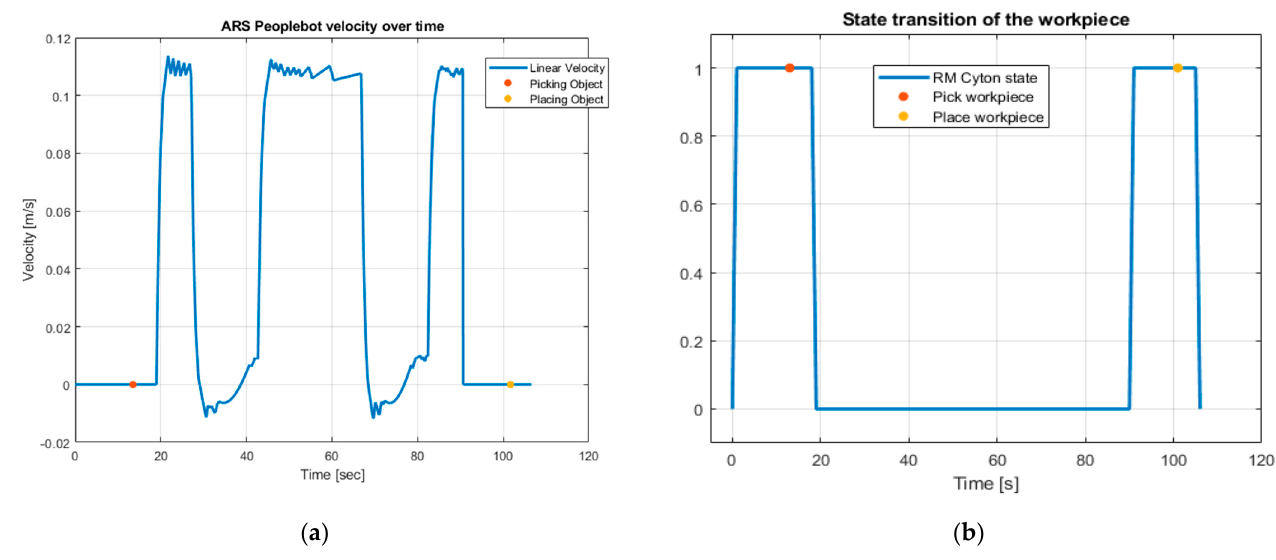
Figure 20. ( a ) ARS PeopleBot velocity evolution over time; ( b ) state transition of the workpiece.